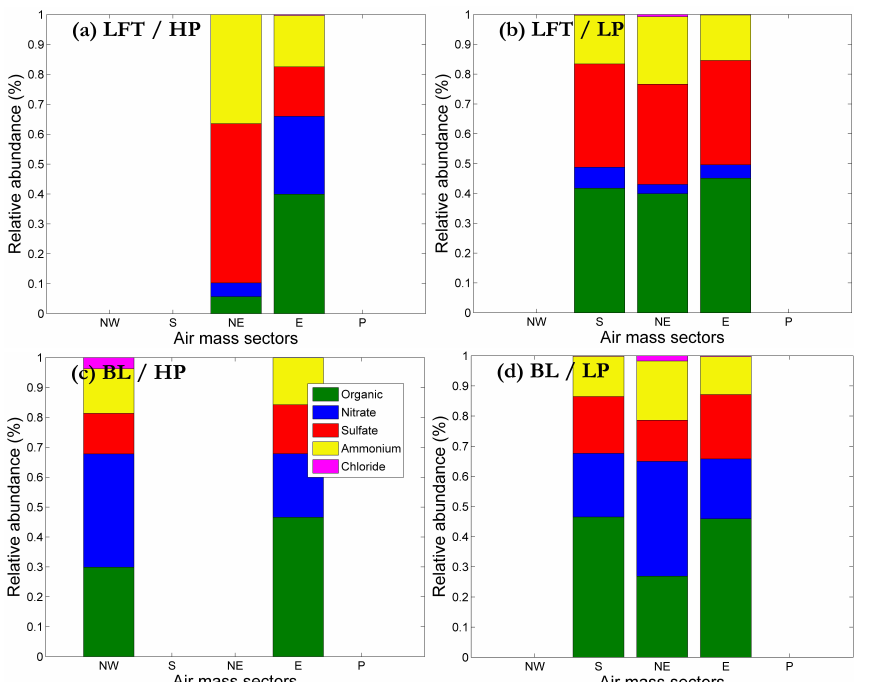
Fig. 5. Bar plot of average relative concentrations of non-refractory submicron aerosol as measured by AMS as a function of the air mass origin (NW: north-west Europe; S: south Europe; NE: north Europe; E: east Europe; P: polar) in the lower free troposphere (LFT) during anticyclonic (HP, a ) and cyclonic (LP, b ) conditions as well as in the boundary layer (BL) during anticyclonic (HP, c ) and cyclonic (LP, d )